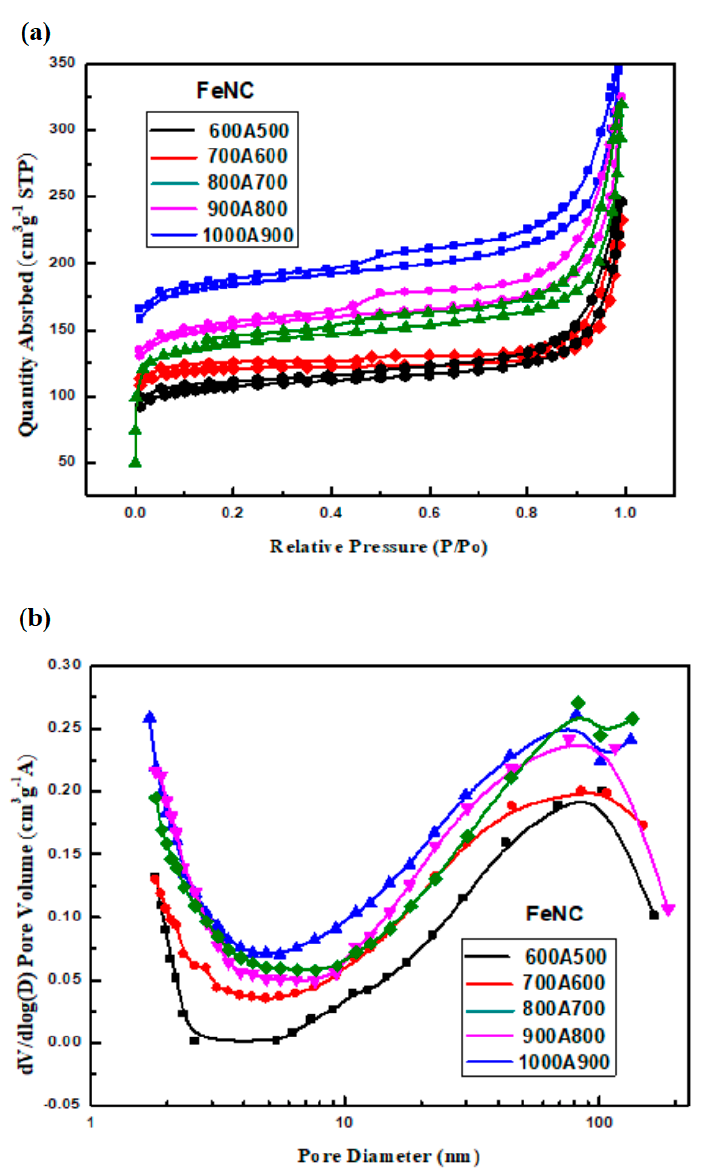
Figure 8. ( a ) N 2 adsorption–desorption isotherms and ( b ) pore size distribution of FeNCs prepared with different calcination methods.